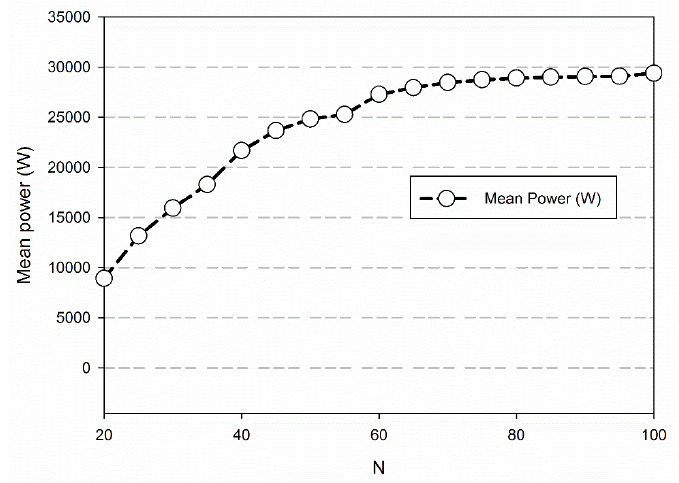
Figure 4. Mean power using different values of (cid:1840) . Constraints are (cid:1848) = 1.5 m. (cid:1852) (cid:2923)(cid:2911)(cid:2934)